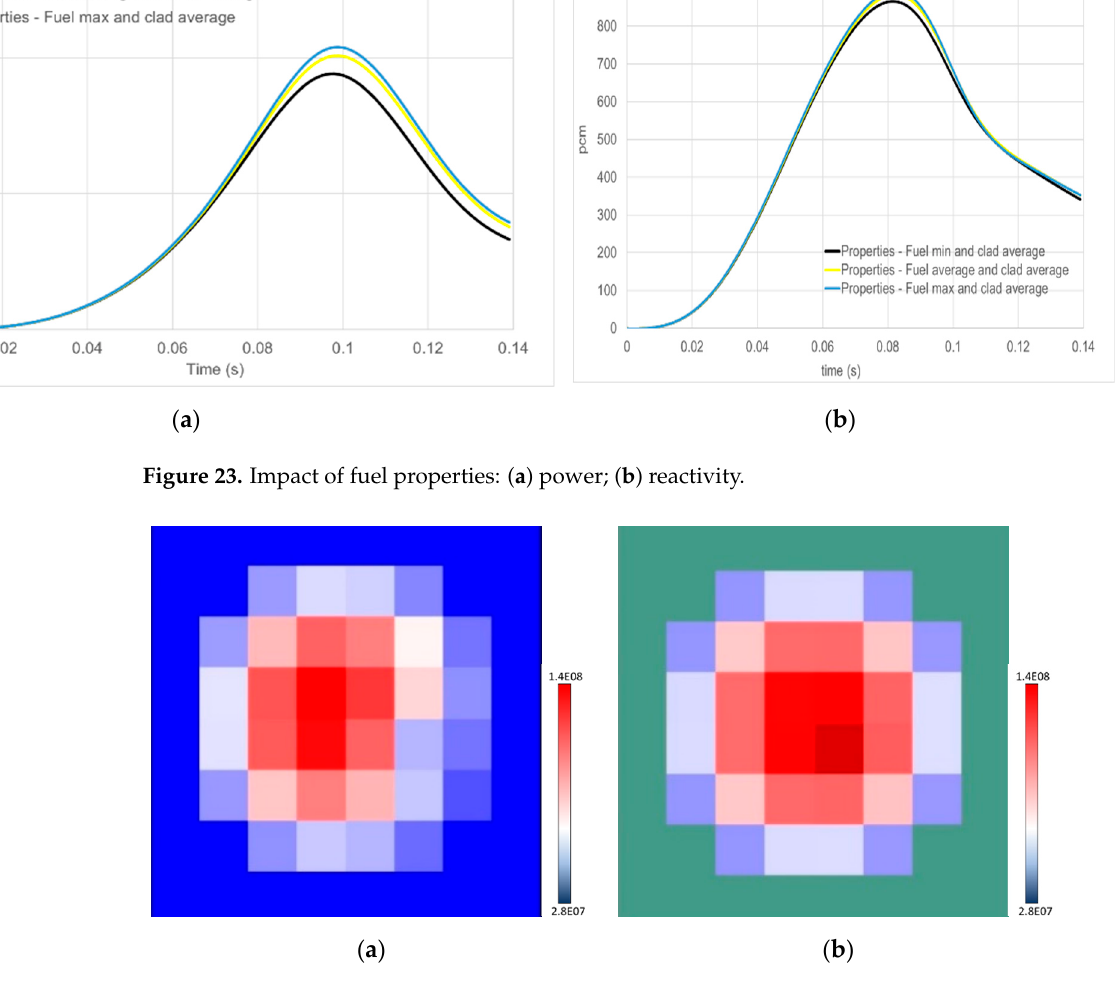
Figure 24. Radial power distribution: ( a ) before transient; ( b ) at the end of the transient.